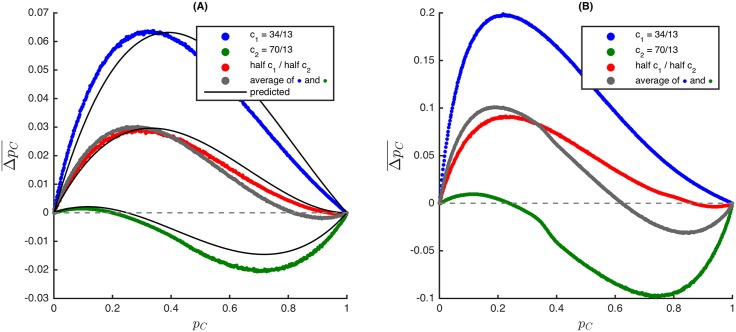
The Snowdrift Games of Fig 1(B) with the stronger selection strengths β = 0.1 (A) and β = 0.5 (B).For each of the three games (with benefit b = 5.0 and costs c
1, c
2, and half c
1/half c
2, respectively), the simulation results differ from the prediction of pair approximation already for β = 0.1 (A). Moreover, for β = 0.5, (B) makes it clear that Theorem 1 no longer holds since the average change in cooperators in the game with mixed costs (red) differs from the average (grey) of these changes for the games with costs c
1 only (blue) and c
2 only (green). Thus, Theorem 1 is peculiar to weak selection.